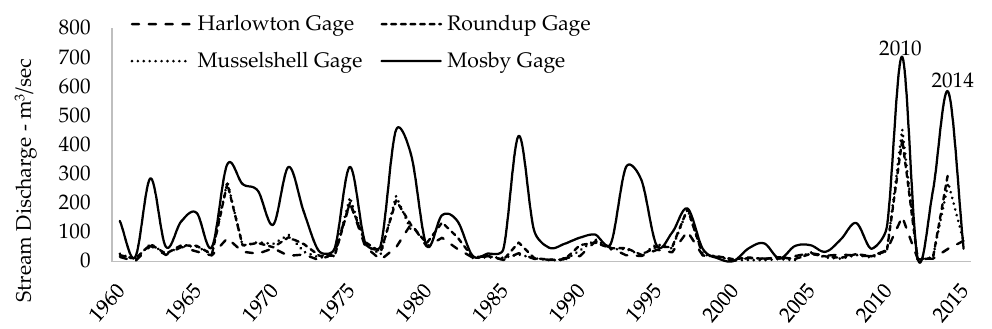
Figure 2. MSR annual peak streamflows as recorded by four USGS stream gauges [53–56].